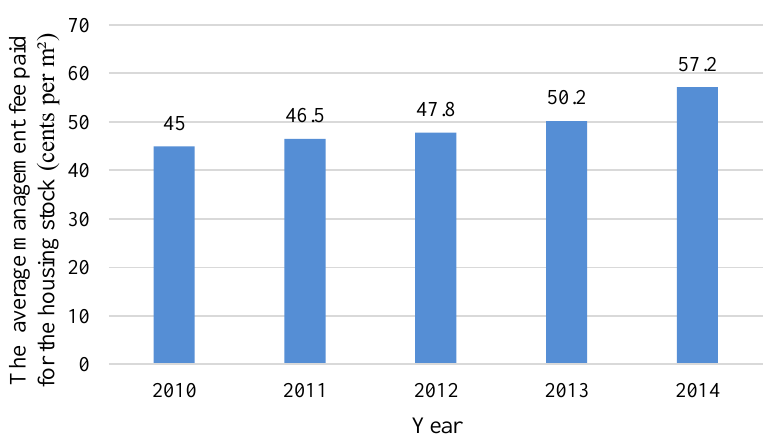
Fig. 4. The average management fee paid for the housing stock in the city of Riga and its region (cents per m²) (Central Statistical Bureau, n.